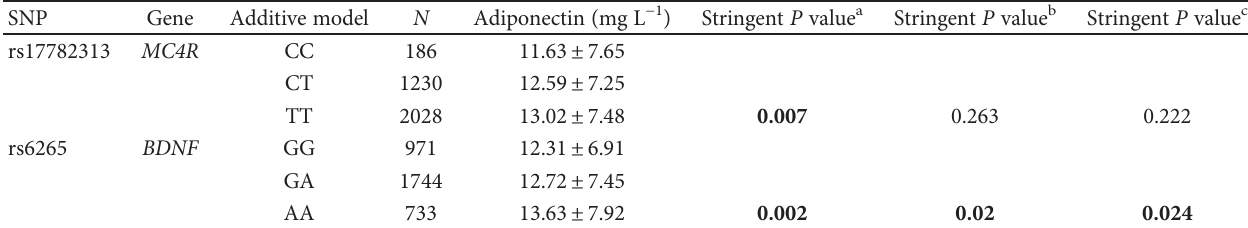
Table 1: Associations of rs17782313 and rs6265 with